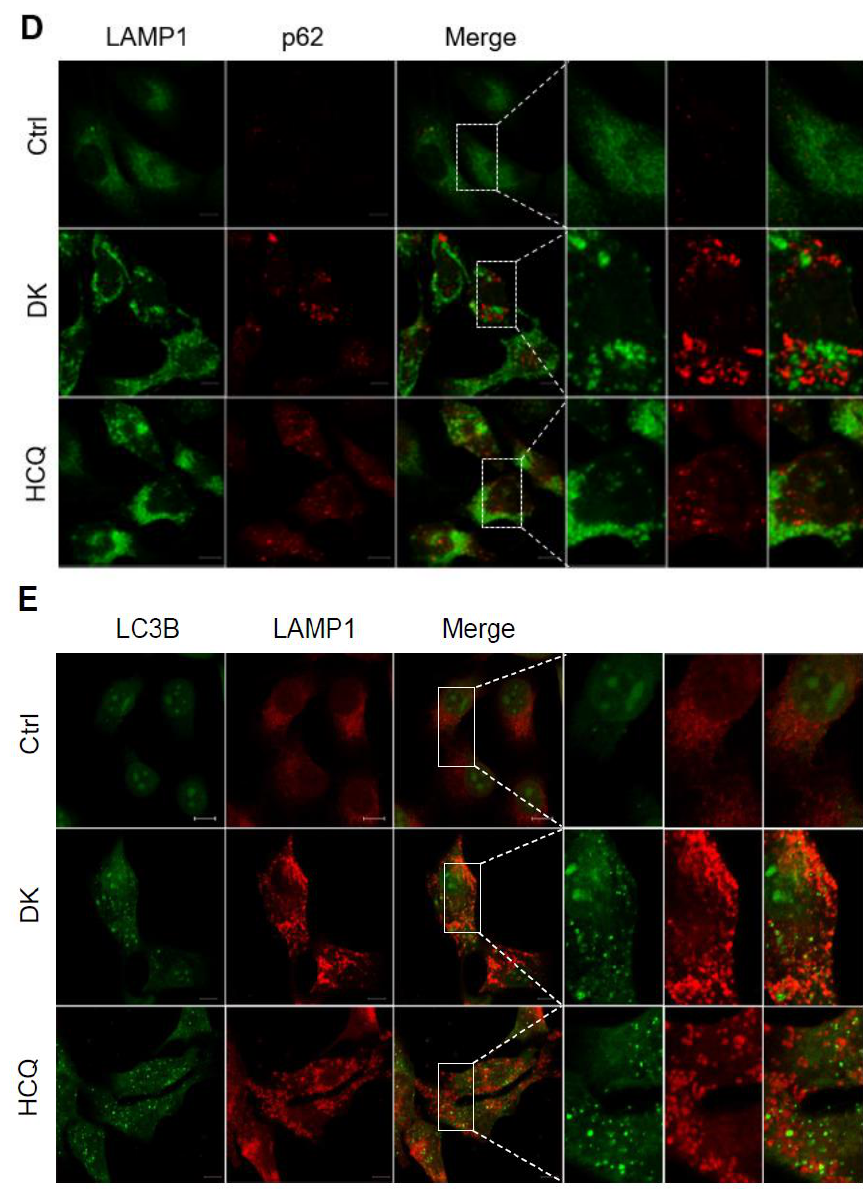
Figure 3. Dieckol (DK) blocks autophagic flux by inhibiting autophagosome-lysosome fusion. ( A ) A375 cells were treated with DMSO or various concentrations of DK for 48 h. The expression levels of microtubule-associated protein 1A/1B-light chain 3 (LC3B), sequestosome 1 (p62), and lysosome-associated membrane protein 1 (LAMP1) were detected by immunoblotting. ( B ) Repre- sentative immunofluorescence images showing the endogenous LC3B and p62. Cells were treated with DMSO or 25 µ M DK for 48 h and then endogenous LC3B and p62 were visualized by im- munofluorescence using primary antibodies, scale bar = 10 µ M. Right panels depict enlarged images of the boxed areas seen in the left panels. ( C ) Representative immunofluorescence images showing colocalization of the GFP-LC3B and mRFP-LC3B by DK treatment. A375 cells were transfected with GFP-mRFP-LC3B. After 24 h, the cells were incubated with DMSO, 25 µ M DK, or 15 µ M HCQ for 48 h and then visualized with confocal microscopy, scale bar = 10 µ M. ( D , E ) Cells were treated the same as in ( B ) and then endogenous LC3B or p62 and LAMP1 were visualized by immunofluorescence using primary antibodies. Right panels depict enlarged images of the boxed areas seen in the left panels. The scale bar = 10 µ M. *** p < 0.001, ** p < 0.01, * p < 0.05 compared to the